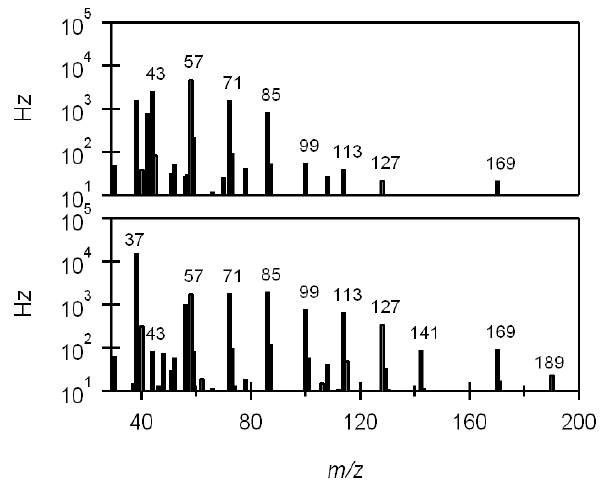
Fig. 2. PTR-MS raw mass spectrum of dodecane (C 12 H 26 ) at 120Td (upper panel) and 80Td (lower panel) drift tube conditions. A clear pattern of C n H 2 n − 1 ion fragments is evident. At 80Td the M − 1 ion ( m/z 169) is more intense. The m/z 189 ion is attributed to the M · H 3 O + cluster.